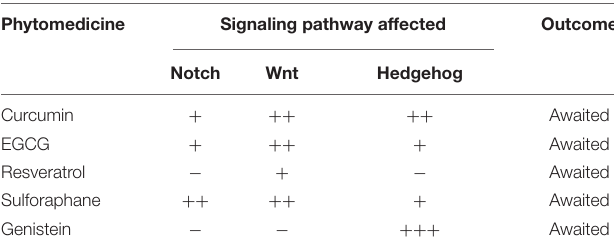
TABLE 3 | Overview of the currently ongoing Phase I/II clinical trials using phytomedicines targeting developmental signaling pathways in solid tumors.